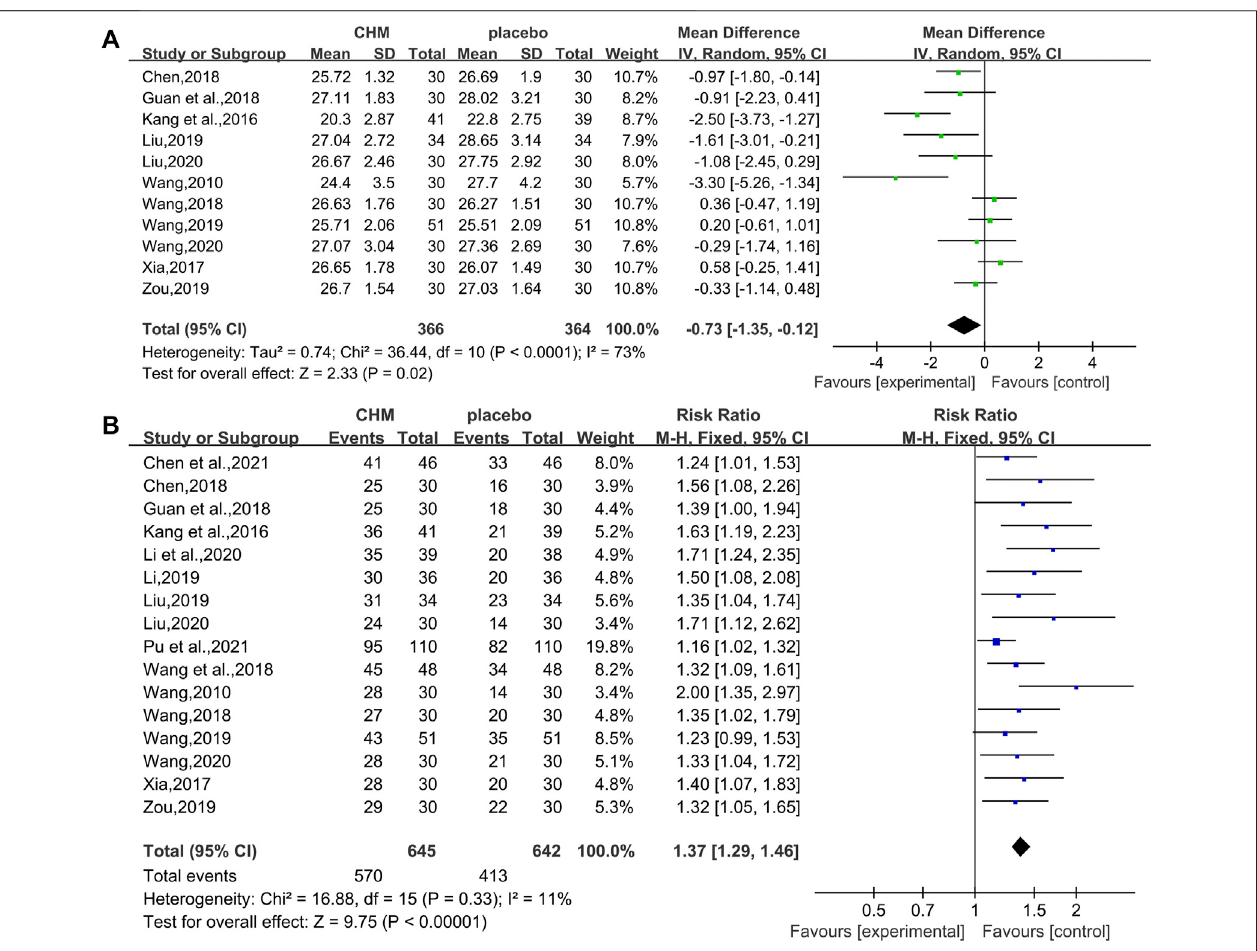
FIGURE 7 | Forest plot for the body mass index and overall effective rate. (A) BMI and (B) overall effective rate.